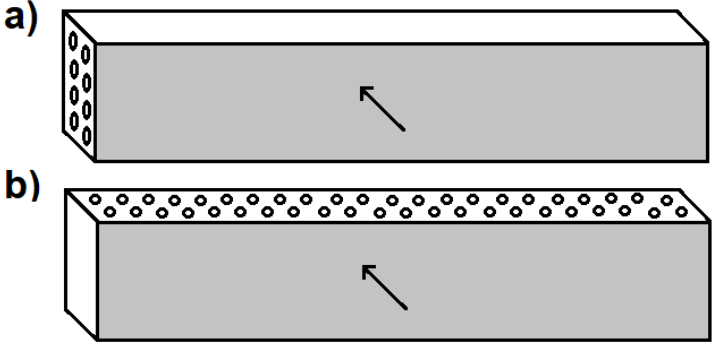
Figure 1. Method of performing impact resistance tests, striking edge ( a ) perpendicular and ( b ) parallel to carbon fibres.